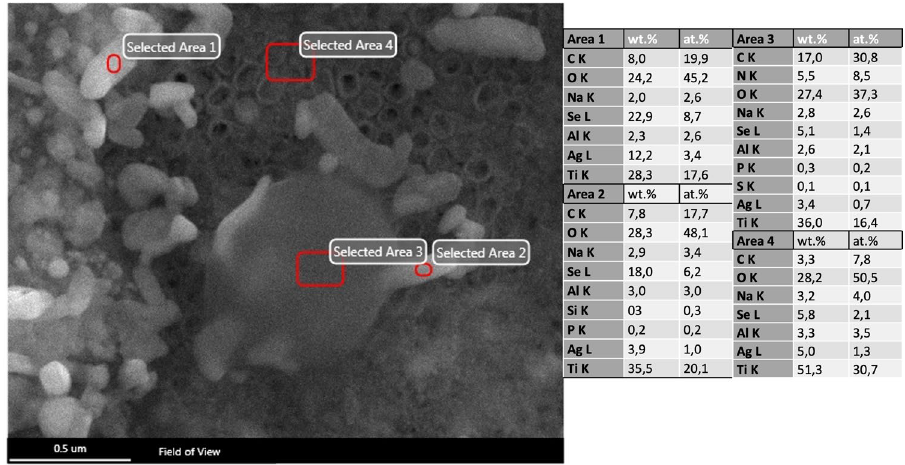
Figure 8. SEM-image and EDX profiles of Ag 2 SepTNT disc showing Ag 2 Se-compounds within the bacterial